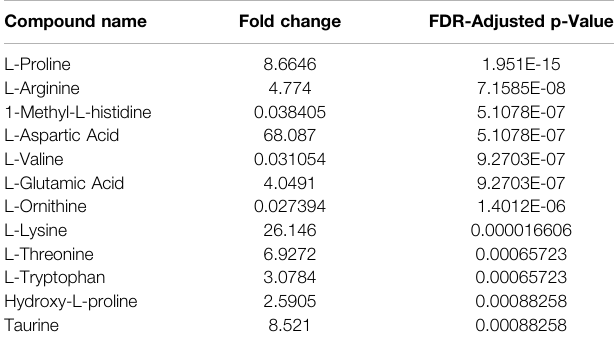
TABLE 2 | Relative fold-change (NP/PF) and signi fi cance of amino acids recovered from Noviplex ™ (NP) cards compared to Para fi lm ™ (PF) dried blood/plasma spots. Signi fi cance testing was conducted using a One-Way- ANOVA, Tukey ’ s post-hoc with Bonferroni-Hochberg FDR correction of p-values (signi fi cance at FDR < 0.05).